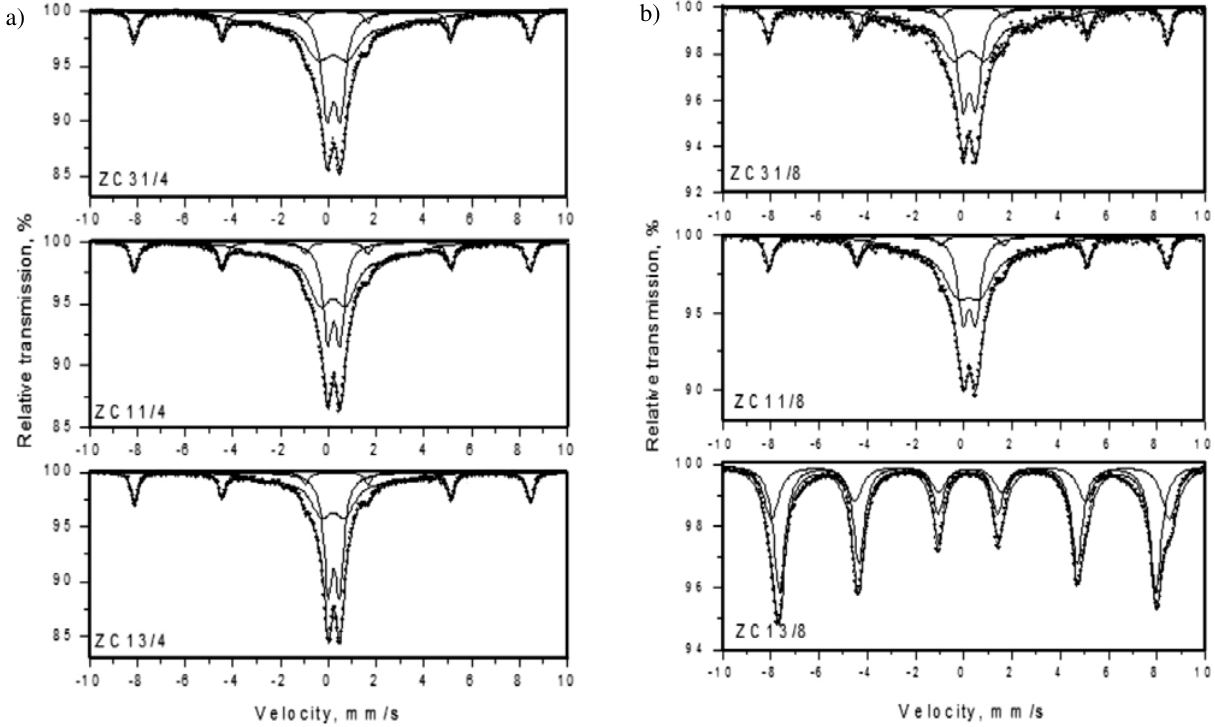
Figure 2. Mössbauer spectra of ZC31/4, ZC11/4, ZC13/4 (a) and ZC31/8, ZC11/8, ZC13/8 (b), from top to bottom.